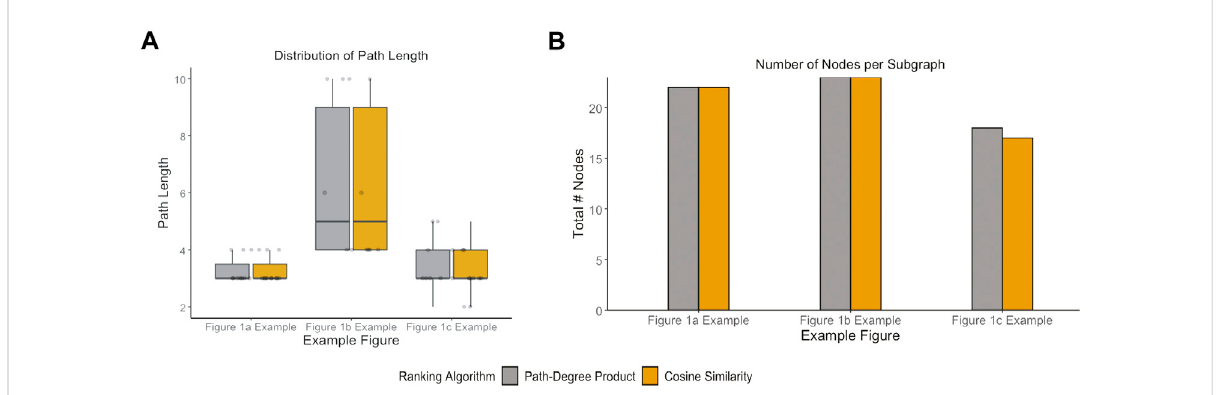
FIGURE 7 Network properties of subgraphs generated by each path ranking algorithm. (A) Path length for all pairs existing in each example fi gure (B) and total number of nodes that exist in the subgraph for each example fi gure.